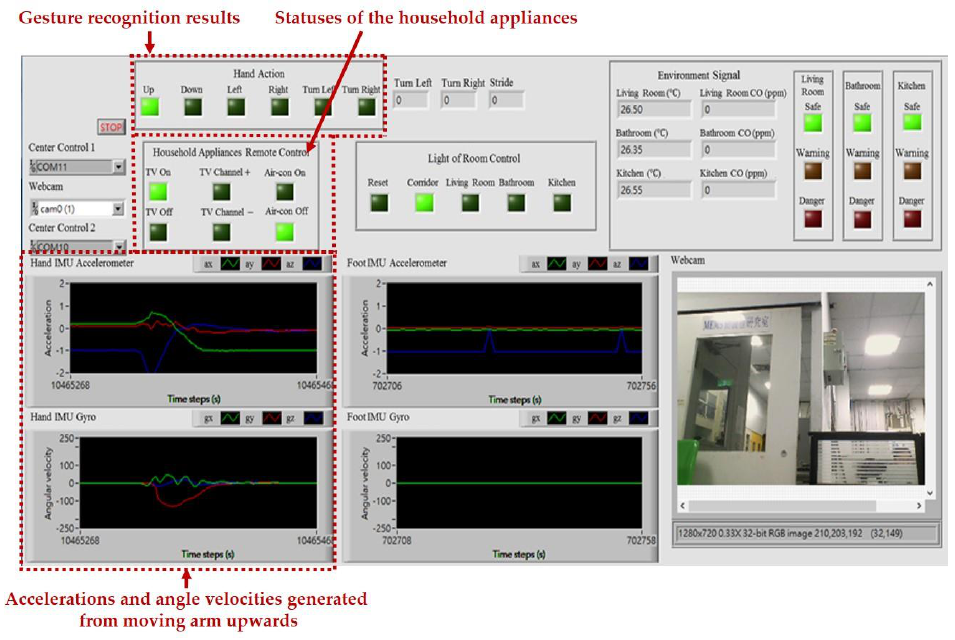
Figure 15. Accelerations and angular velocities generated from moving arm upwards, gesture recognition results, and statuses of the household appliances shown on the intelligent monitoring interface.